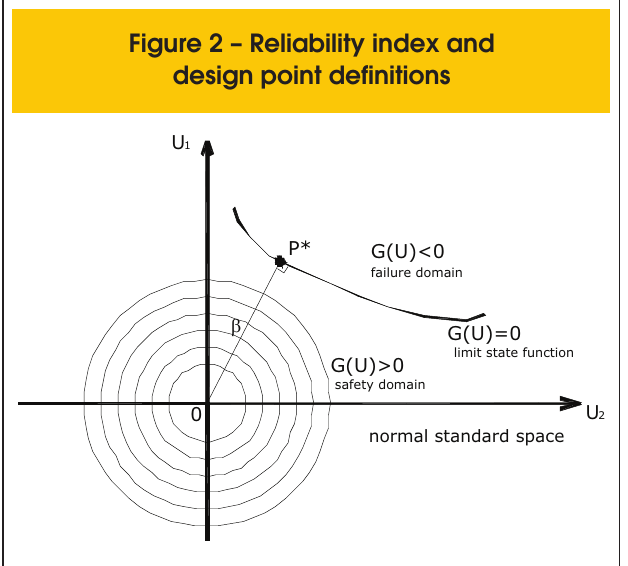
Figure 2 – Reliability index and